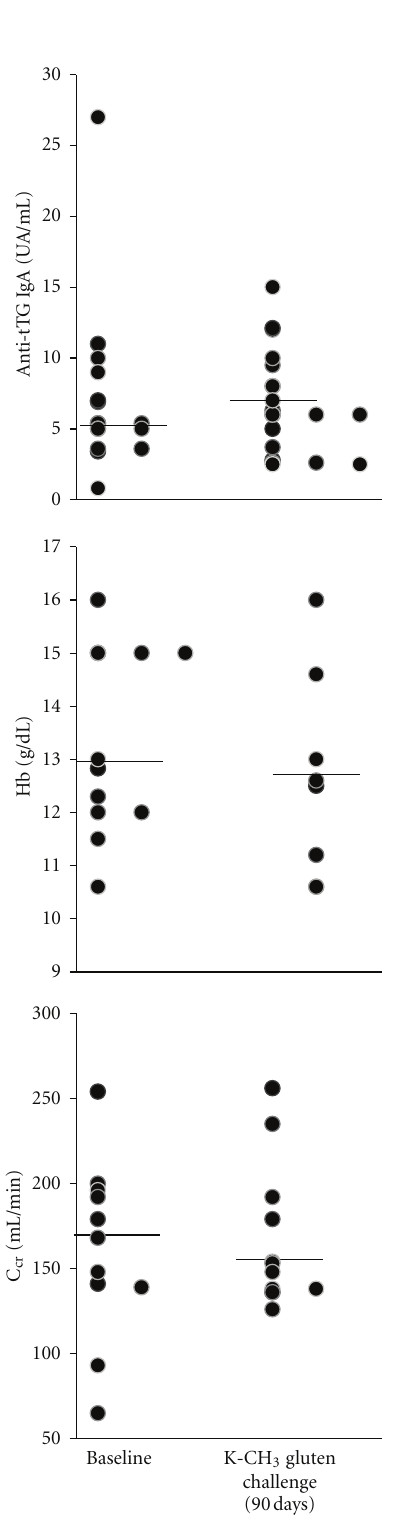
Figure 5: Laboratory investigation of patients in the experimental group. Anti-tTG IgA titre (UA/mL; n.17), haemoglobin content (g/dL; n.11) and creatinine clearance (mL/min; n.11) following a 90-day (K-CH 3 )-transamidated gluten challenge. Bars indicate medians. Statistical evaluation of the data was performed using theWilcoxon signed-rank test. The level P < 0 . 05 was selected to denote a significant di ff